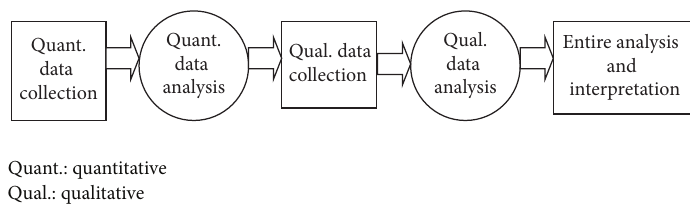
Figure 1: Sequential explanatory mixed methods